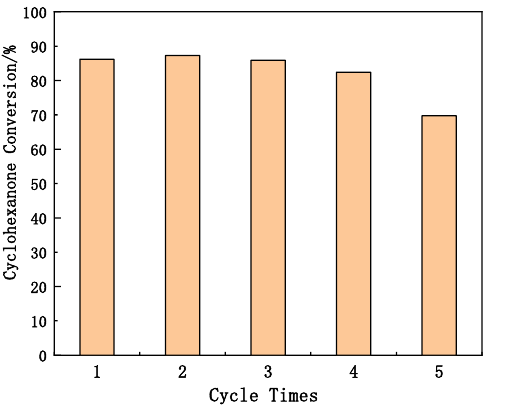
Figure 15. The stability of the U-90-08-10 zeolite of ketalization reaction of glycerol with cyclohexa-